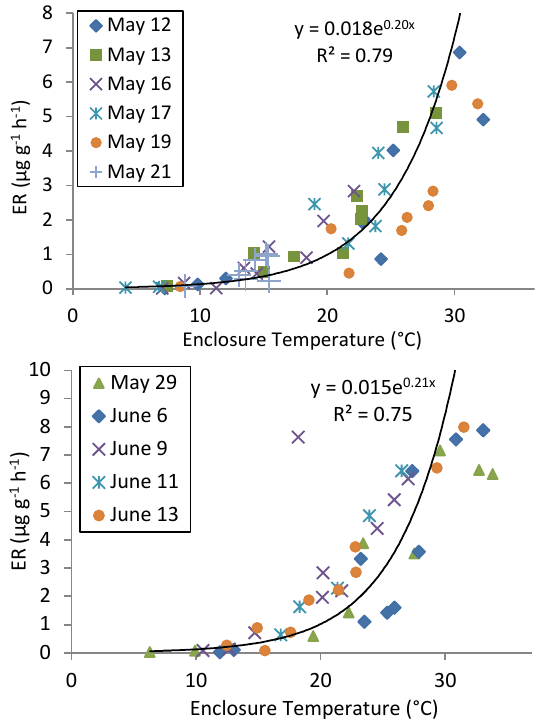
Fig. 6. Emission rates (expressed as the sum of monoterpenes) from horse chestnut as a function of temperature during blooming (left), and after the end of the blooming period (right).